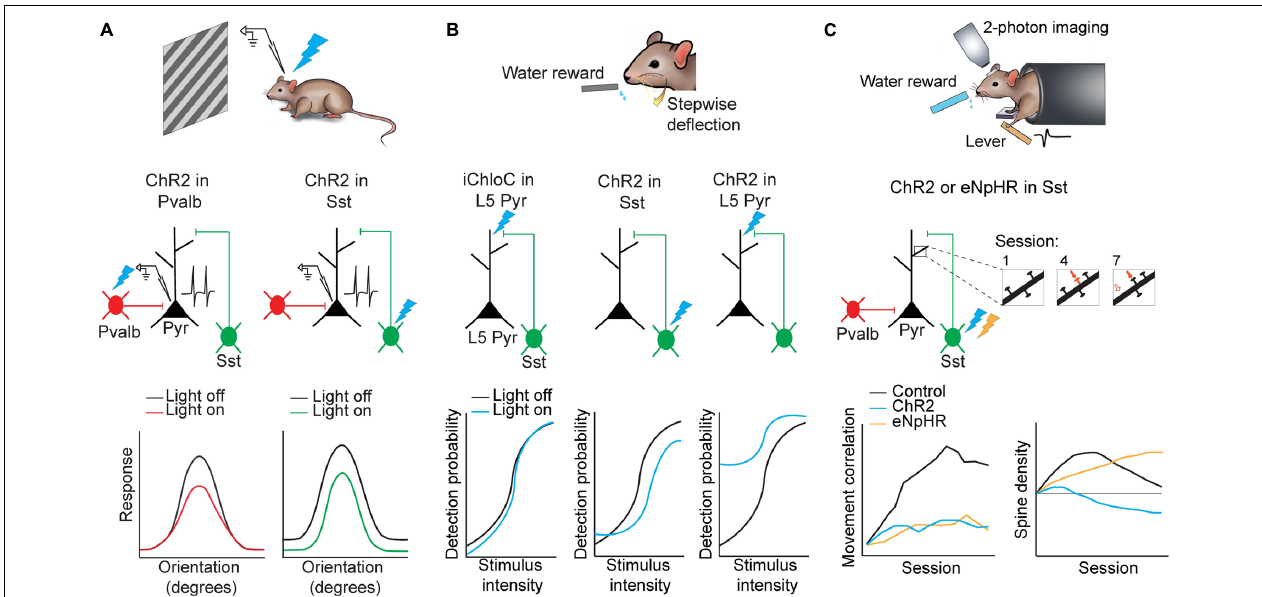
FIGURE 2 | Applications of optogenetics in the analysis of circuit functions. (A) Mice were presented with oriented drifting gratings while in vivo cell-attached recordings of putative pyramidal neurons in the visual cortex were performed. Either Pvalb or Sst interneurons were photoactivated using ChR2. Pvalb interneuron photoactivation (left) resulted in divisive inhibition of pyramidal neurons where suppression was stronger at orientations where pyramidal neuron responses were also stronger. Sst interneuron photoactivation (right) resulted in subtractive inhibition where suppression was uniform along all orientations. Adapted from Wilson et al. (2012). (B) Mice were trained to lick for a water reward in response to whisker stimulation of varying intensities. Perceptual detection as a function of stimulus intensity formed a sigmoid curve. When L5 pyramidal neuron apical dendrites were photoinhibited (iChloC) or when Sst interneurons were photoactivated (ChR2), the curve shifted to lower detection probabilities. When L5 pyramidal neuron apical dendrites were photoactivated (ChR2), the curve shifted to higher detection probabilities. Adapted from Takahashi et al. (2016). (C) Mice were trained to press a lever following an auditory cue to obtain a water reward. Two-photon imaging was performed in M1 throughout learning to track dendritic spine dynamics in pyramidal neurons. Control animals developed a stereotyped lever-press movement with learning but this was impaired if Sst interneurons were photoactivated (ChR2) or photoinhibited (eNpHR) (bottom left). Furthermore Sst interneuron photoinhibition resulted in increased stabilization of dendritic spines while photoactivation resulted in increased elimination. (bottom right). Adapted from Chen et al.